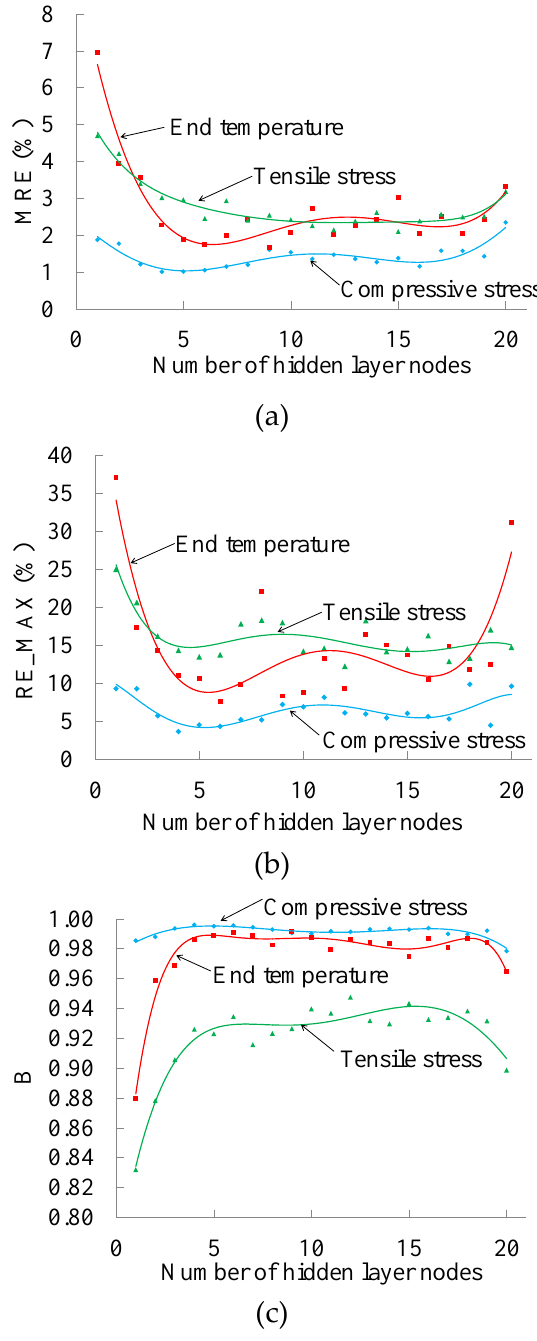
Figure 3. Performance assessment ( a ) RE_MAX — maximum relative error of all testing results, ( b ) MRE — mean relative error, and ( c ) B — coefficient of determination of the BP-ANN models with different node numbers in the hidden layer.